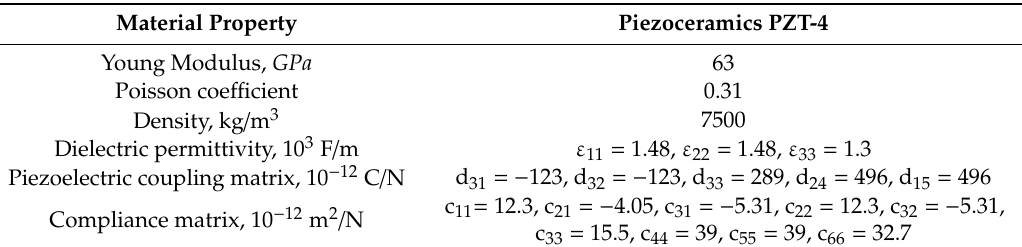
Table 1. The properties of the material used for numerical simulation.